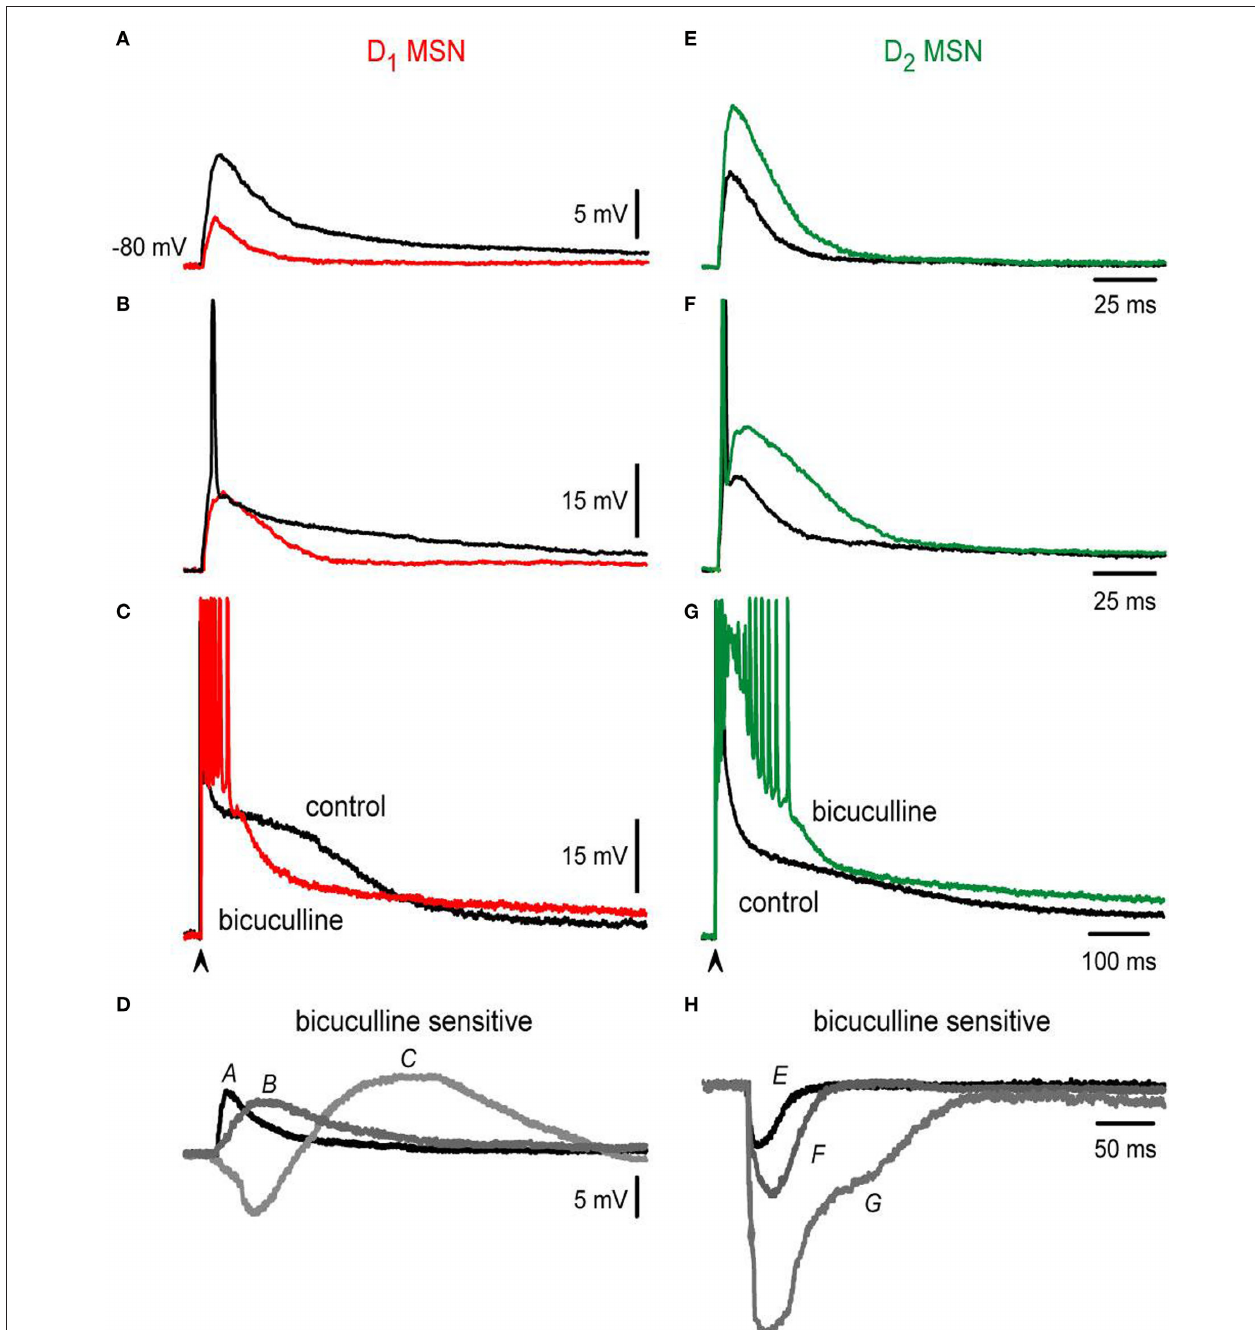
responses, respectively. Notice that blockade of GABAergic synapses impedes FiGure 3 | Bicuculline actions differ in D - and D -MSNs at different 1 2 the firing of action potentials in D -MSNs (B) and elicits a local response that stimulation intensities. (A,e) Blockade of GABAergic synapses during 1 distorts synaptic kinetics in D -MSNs (F) . (C,G) Blockade of GABAergic subthreshold synaptic responses (black trace = control; colored trace = after 2 synapses in suprathreshold synaptic responses. Superimposed traces cross bicuculline): both responses are depolarizing and have a similar amplitude in each other in D -MSNs and do not cross in D -MSNs. (D–H) Digital subtractions control conditions (about 10 mV). Notice that GABAergic blockade reduces the 1 2 of traces in (A – G) : Bicuculline-sensitive component helps in depolarizing all synaptic response in D - and increases the synaptic response in D -MSNs. There 1 2 D -MSNs synaptic responses, except at the beginning of the suprathreshold is no hyperpolarizing synaptic component in any response in spite of both being 1 responses. In contrast, bicuculline enhanced D -MSNs synaptic responses at all bicuculline-sensitive: inhibition is depolarizing in both cases. (B,F) Blockade of 2 stimulus strengths. Inhibition is depolarizing and even excitatory in D -MSNs GABAergic synapses during threshold synaptic responses. Again, a decrease 1 whereas it always represses D -MSNs (shunting and an increase in the responses were observed in D - and D -MSNs synaptic 2 1 2